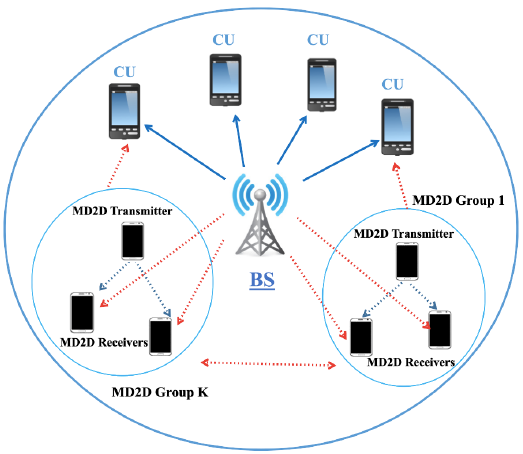
Figure 1. System model.